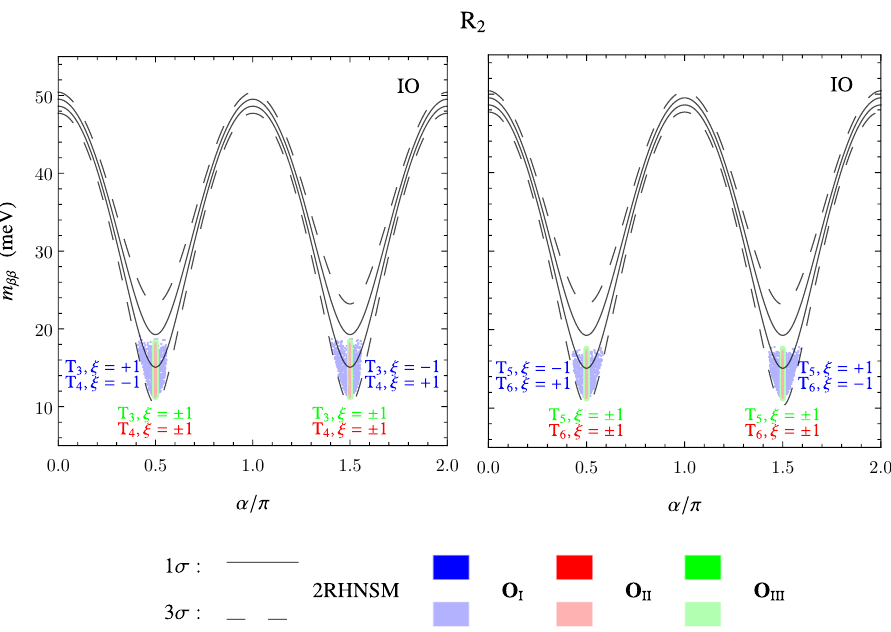
Figure 8 . Allowed regions in the ( (cid:11) , m (cid:12)(cid:12) ) plane for the (R 2 , T 3 ; 4 , (cid:24) = (cid:6) 1) and (R 2 , T 5 ; 6 , (cid:24) = (cid:6) 1) combinations (left and right plots, respectively), in the case of IO and O of the types O I-III . The light (dark) colored regions were obtained varying (cid:18) ij , (cid:1) m 2 and (cid:14) within the 3 (cid:27) (1 (cid:27) ) experimental ij ranges given in table 1. The solid (dashed) lines are the contours of the 1 (cid:27) (3 (cid:27) ) m (cid:12)(cid:12) regions allowed by the general 2RHNSM previously shown in (cid:12)gure